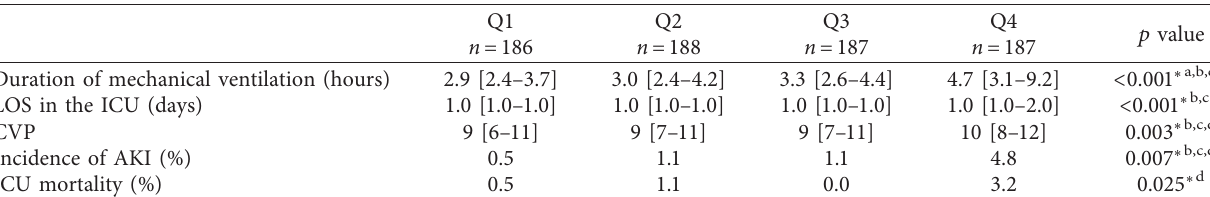
Figure 1: Fluid balance and duration of mechanical ventilation. Table 3: Univariate analyses.